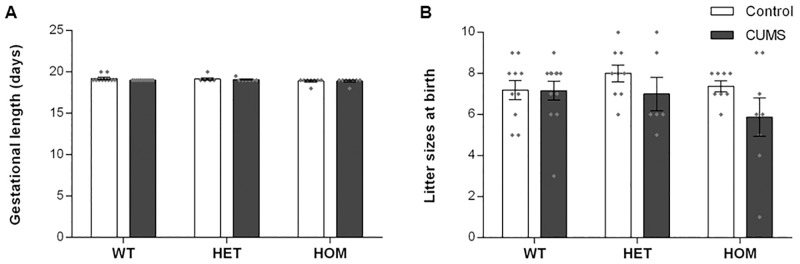
CUMS exposure in Shank3ex4-9 mutant dams did not affect pregnancy outcomes.(A) Gestational length, and, (B) litter size at birth were not affected by Shank3ex4-9 genotypes and CUMS exposure. WT: Wildtype; HET: Heterozygous; HOM: Homozygous. N for gestational length = Control (10 WT, 7 HET and 8 HOM) and CUMS (10 WT, 6 HET and 8 HOM). N for litter sizes = Control (10 WT, 9 HET, and 8 HOM) and CUMS (12 WT, 6 HET and 8 HOM). Individual data points are represented by diamonds. Bars are mean ± SEM and P<0.05 statistically significant by 2-way ANOVA.